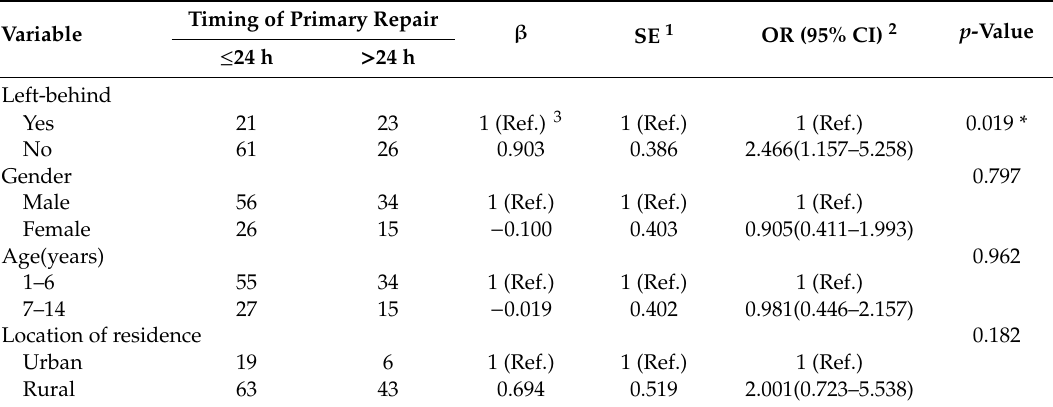
Table 3. Logistic regression analysis of the timing of primary